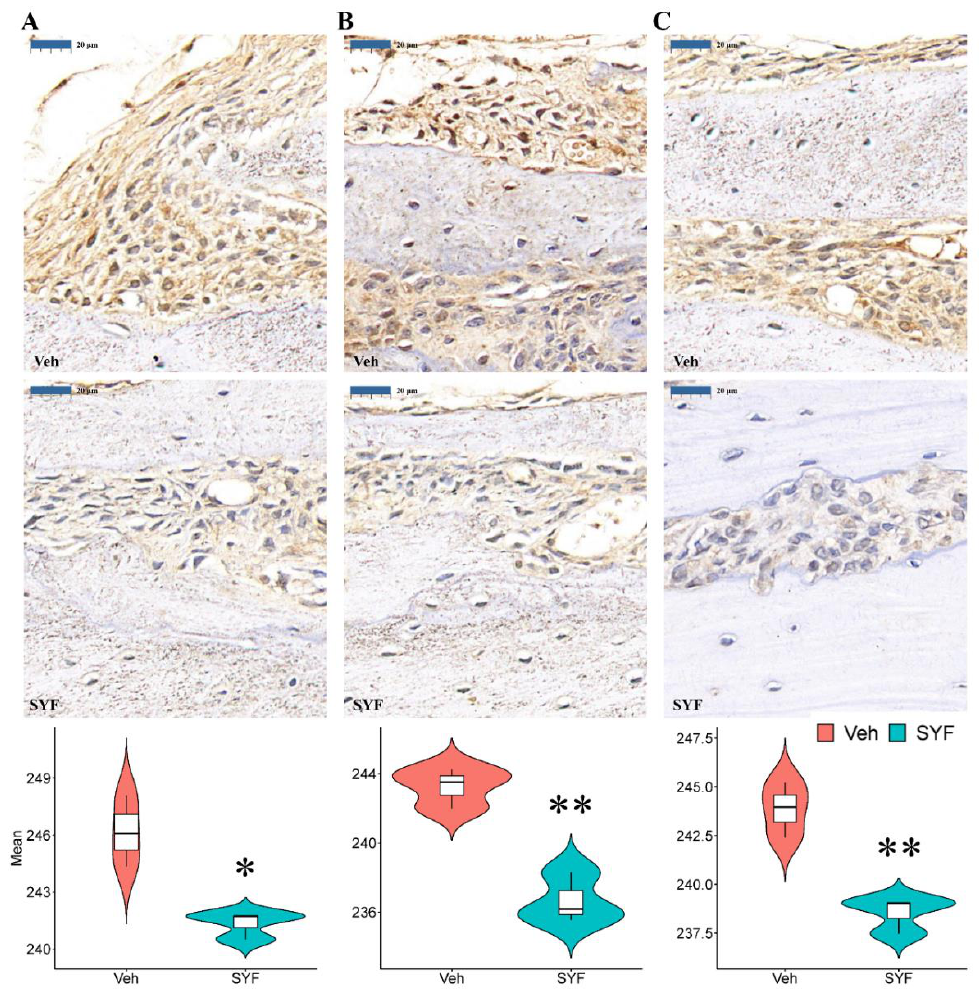
Figure 8. SYF reduced STAT3, MMP-2 and MMP-9 expression in bone metastases. Representative photographs and quantitative analysis of STAT3 ( A ), MMP-2 ( B ), and MMP-9 ( C ) IHC staining in bone metastases. * p < 0.05, ** p < 0.01 vs. Veh group.